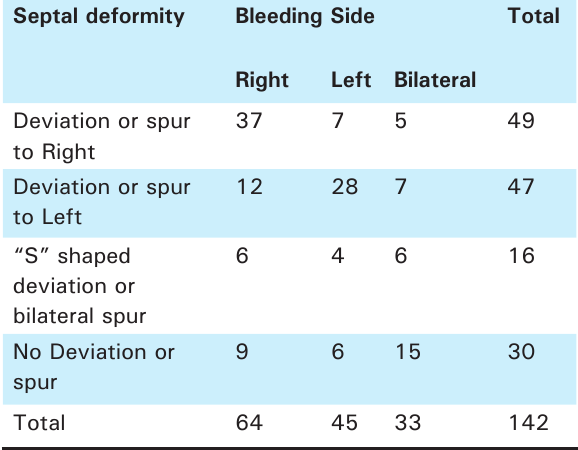
table 1. Deviated Nasal septum and laterality of